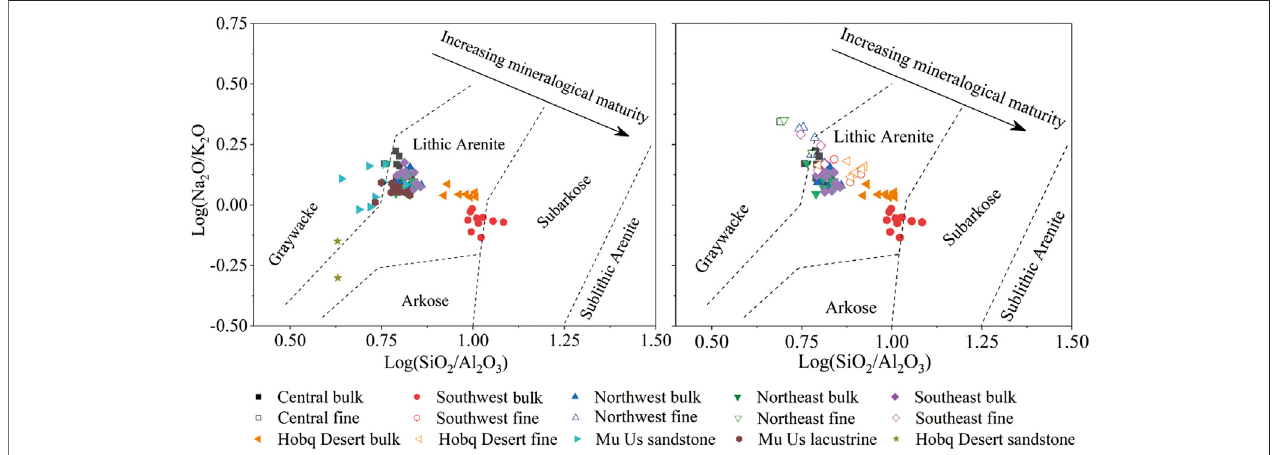
FIGURE 9 | Plots of mineralogical maturity for sediments in the Ordos Deserts. Data of sandstone and lacustrine sediments in Mu Us and the Hobq Desert is from Liu and Yang (2018).